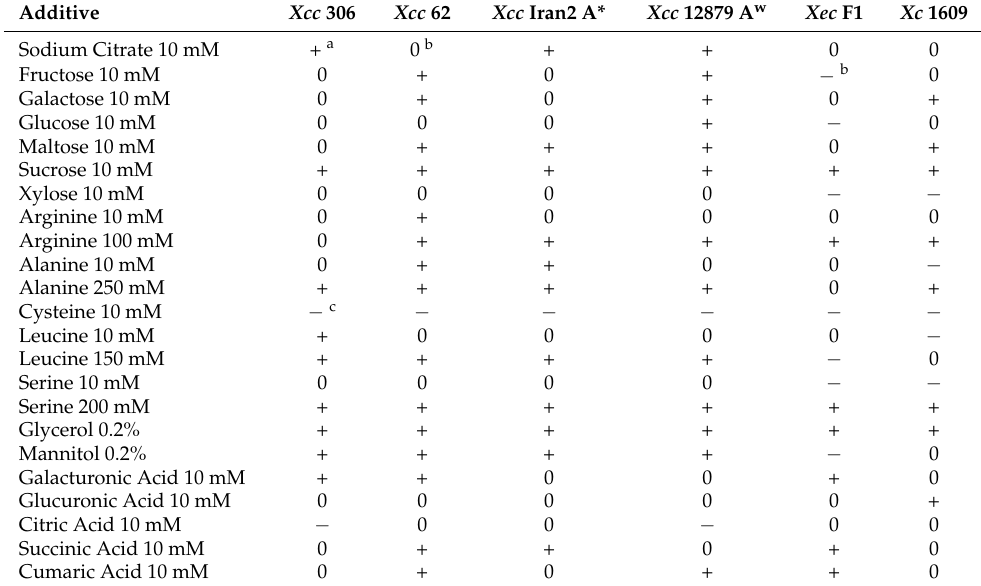
Table 4. Chemotactic response of the species and strains of Xanthomonas pathogenic on citrus and